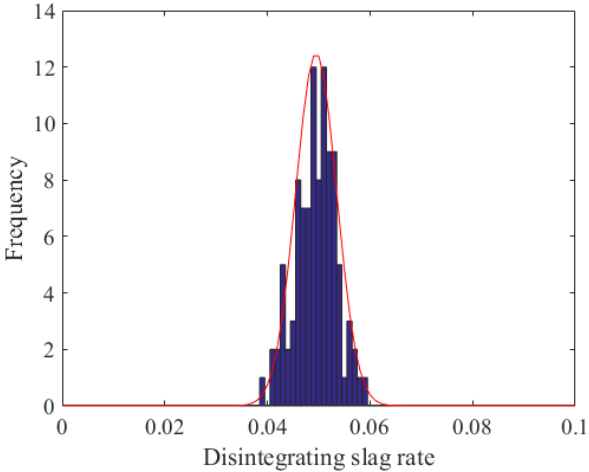
Figure 18. The distribution of disintegrating slag rate of rhizome TCM.